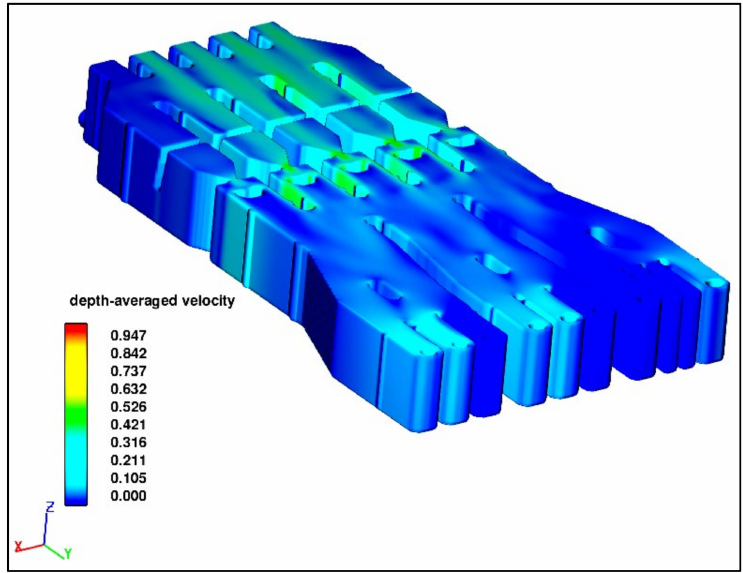
Figure 20. Velocity contours field that resulted from the 3D